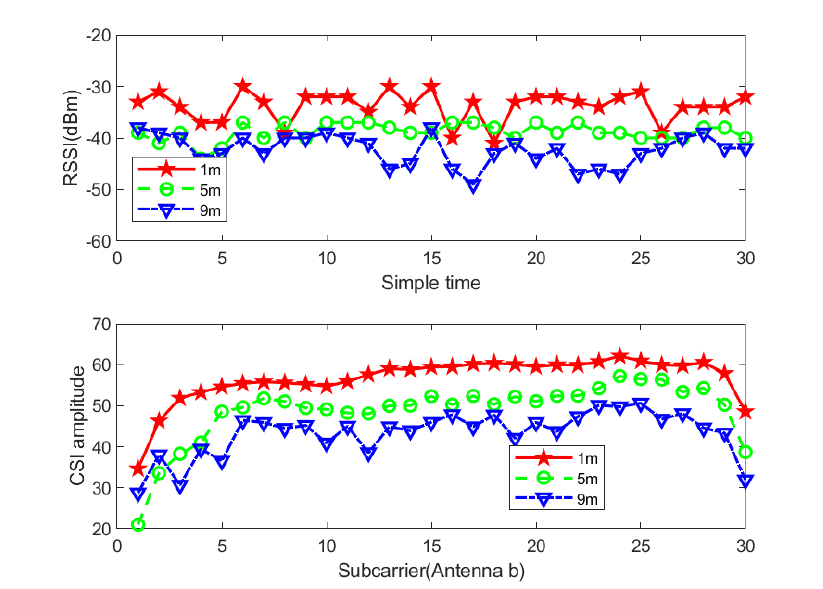
Figure 2. Comparison of the stability between the sampled RSSI value and the amplitude of the CSI sampled on channel